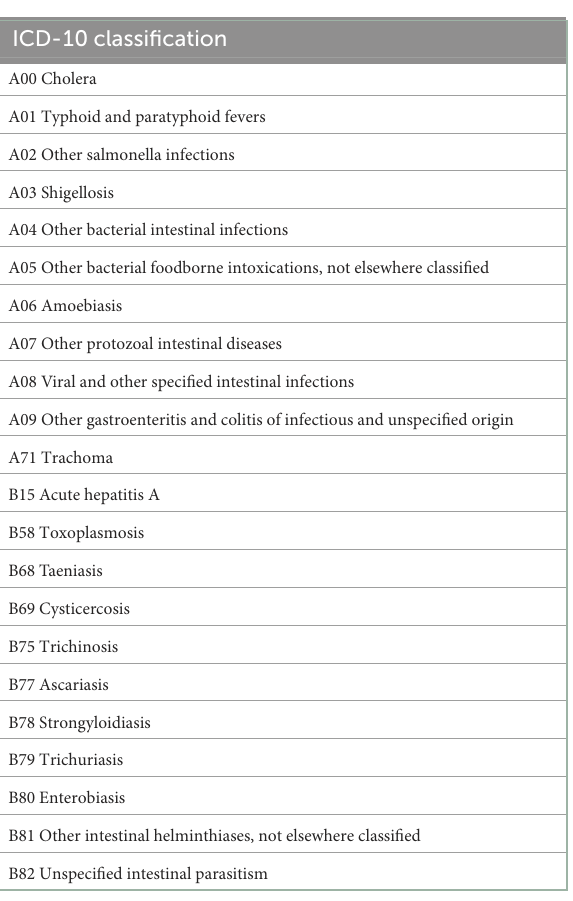
TABLE 2 ICD-10 Classification of waterborne diseases